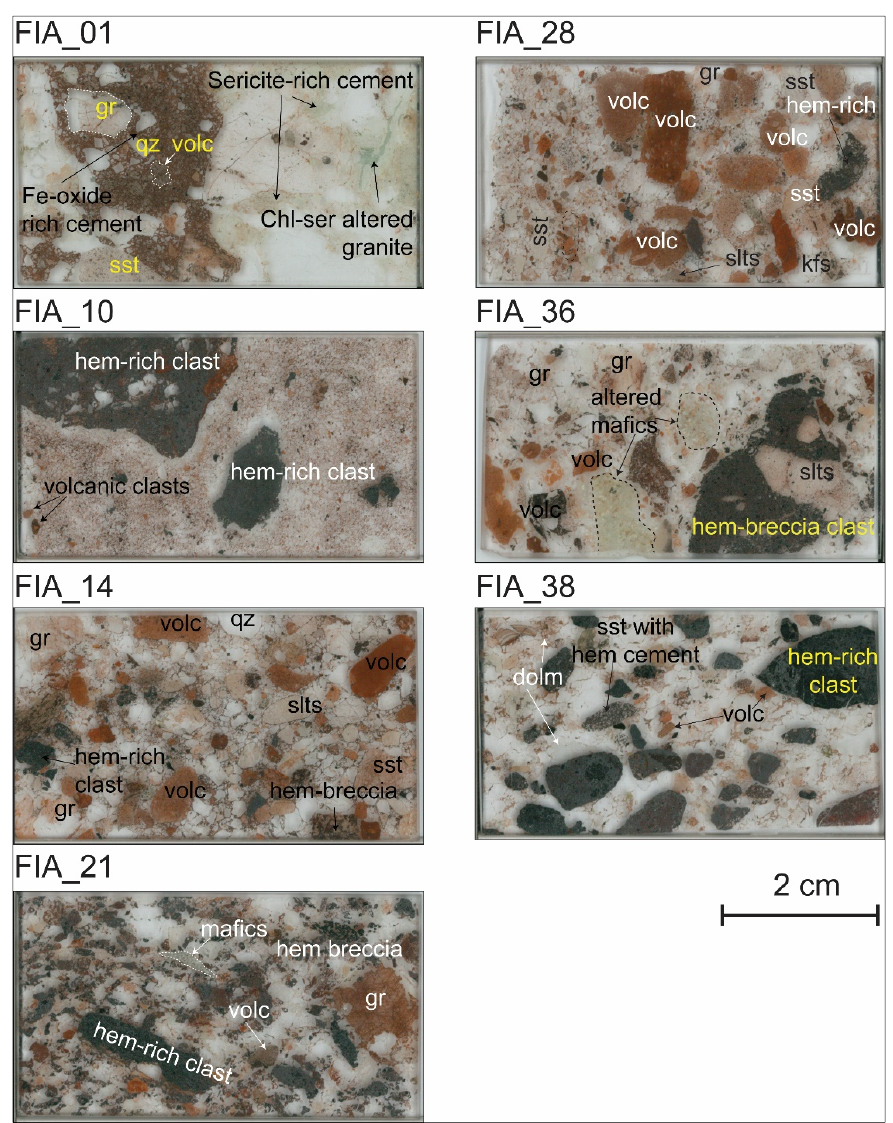
Figure 2. Thin section photos of the basal diamictite samples used in this study. Drill hole locations are shown in Figure 1b. Mineral abbreviations: gr, granite; qz, quartz; volc, volcanic; sst, sandstone; kfs, k-feldspar; slts, siltstone; chlr-ser, chlorite–sericite; hem, hematite.